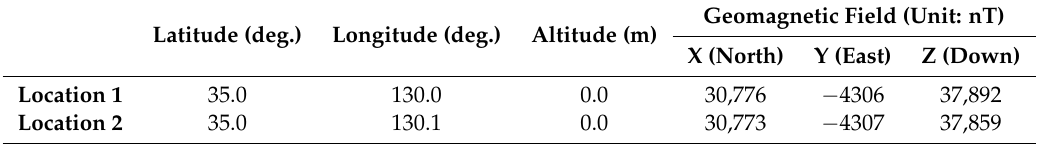
Table 6. Comparison of geomagnetic field of two locations 9.1 km apart, for the date of 9 January 2019.